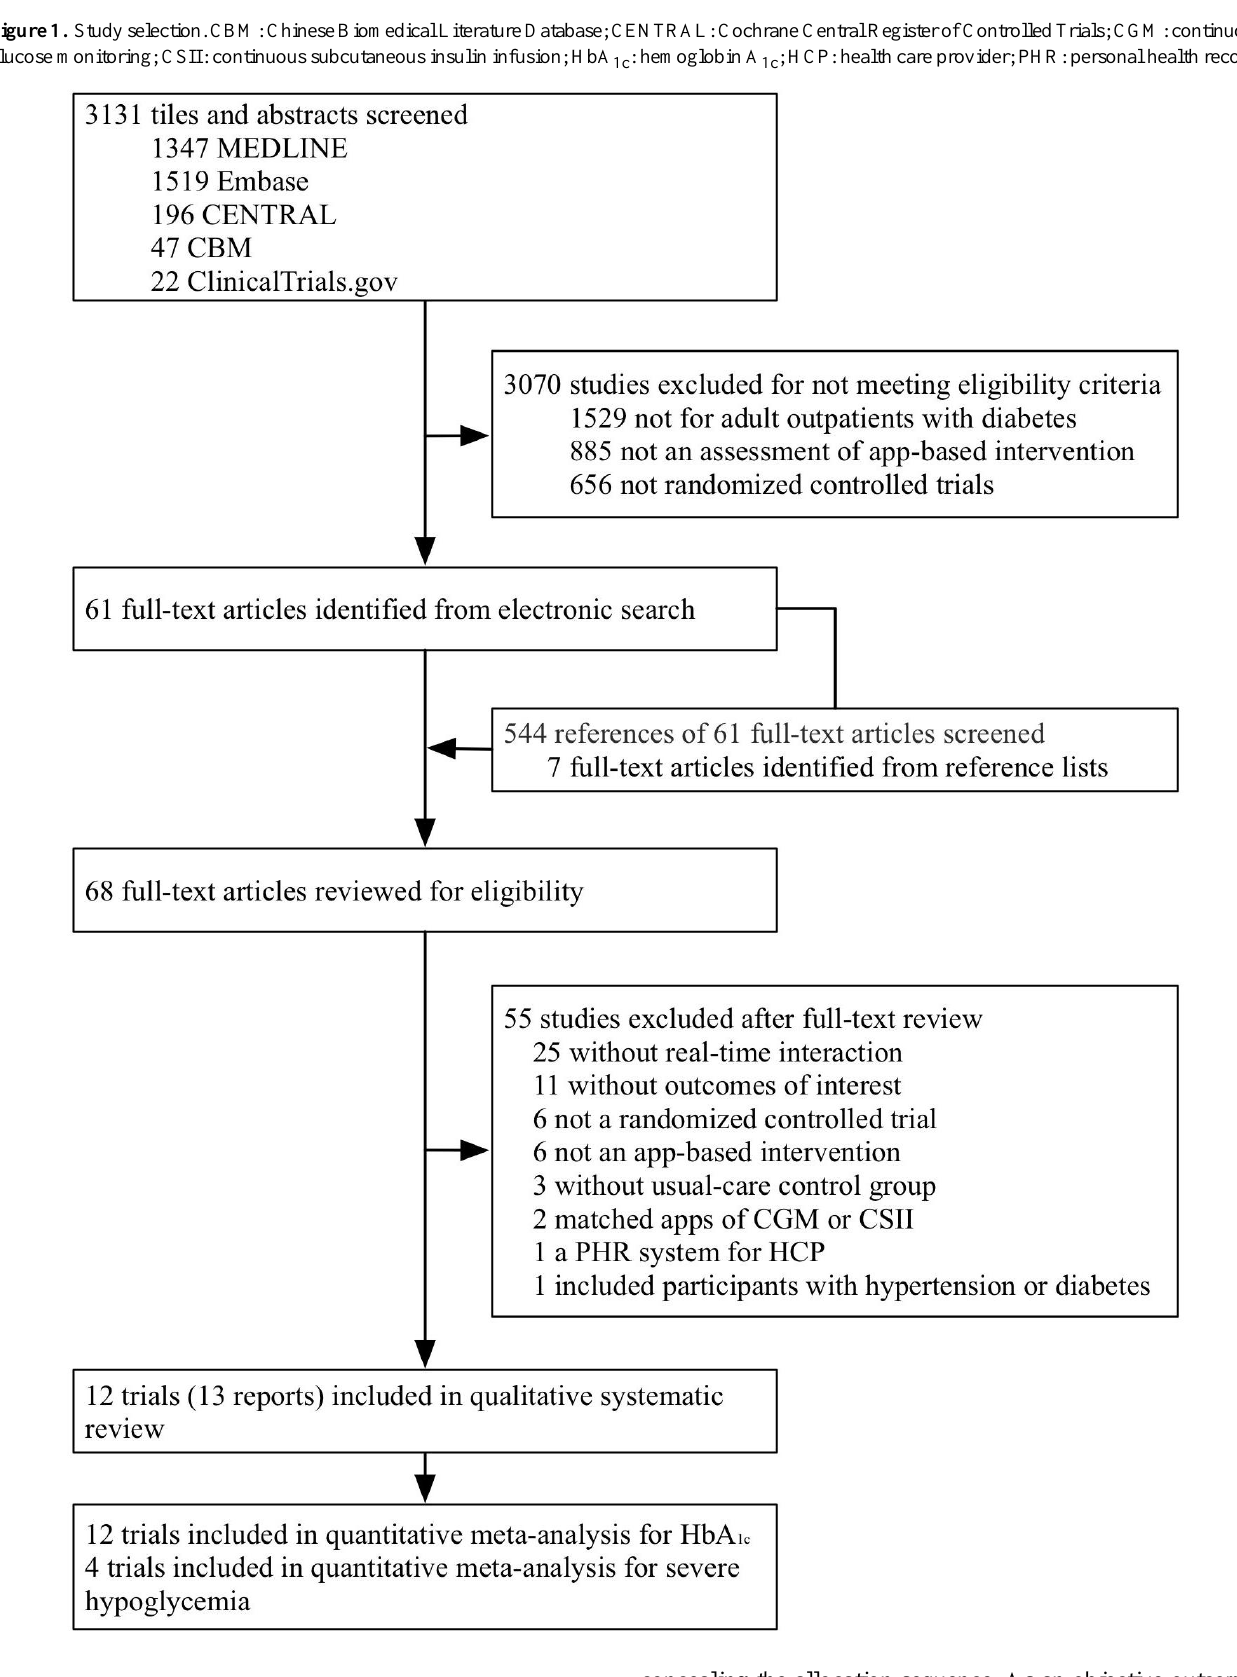
Figure 1. Study selection. CBM: Chinese Biomedical Literature Database; CENTRAL: Cochrane Central Register of Controlled Trials; CGM: continuous